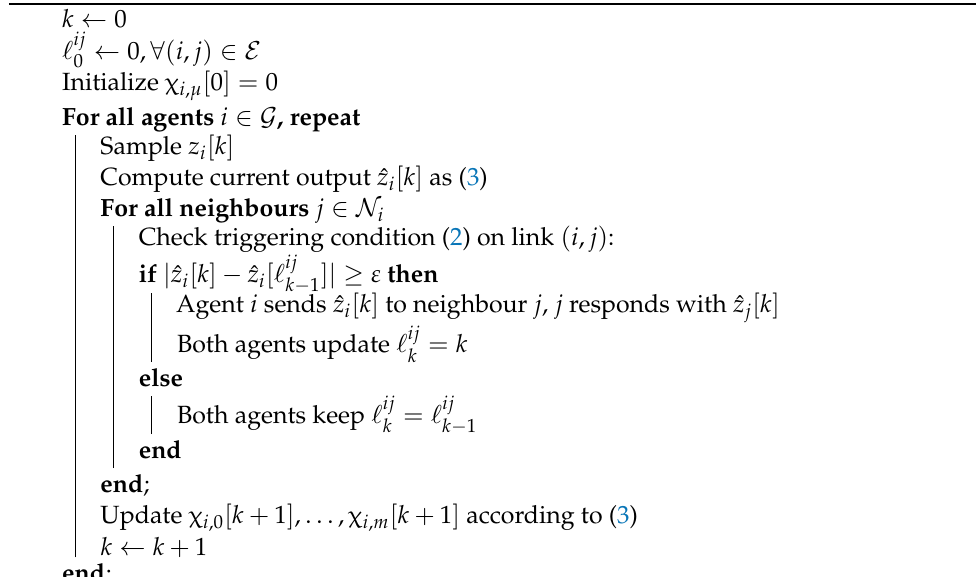
Algorithm 1: Exact dynamic consensus with event-triggered